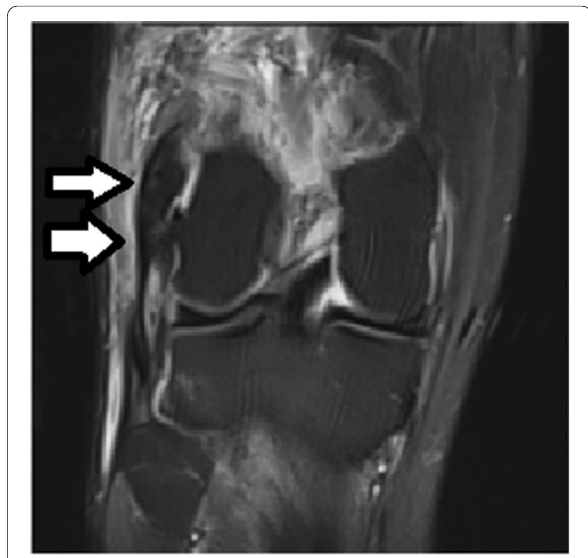
Fig. 7 A 43‑year‑old male patient suffered instability and swelling, and pain of the right knee following a road traffic accident. Coronal PDFS image showing avulsion fracture of the lateral femoral condyle at the site of attachment of the LCL and popliteal tendon